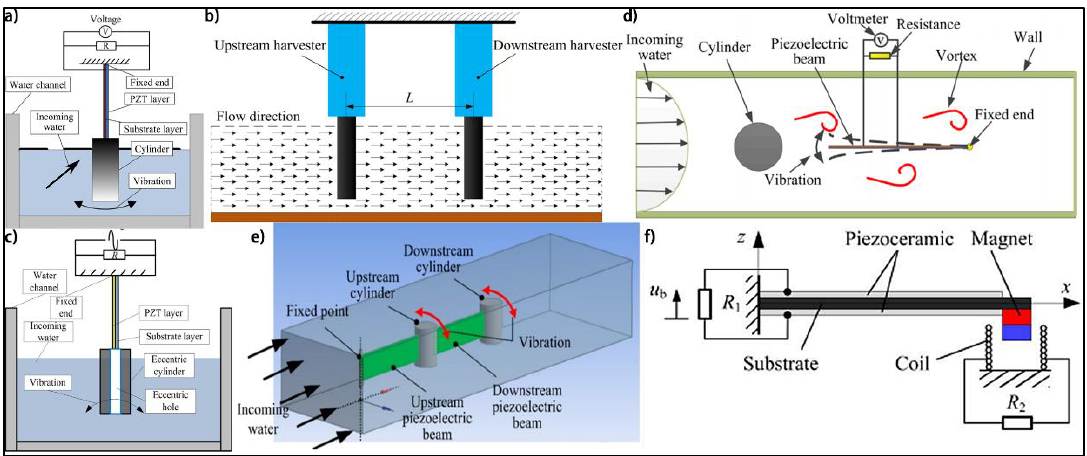
Figure 8. In-depth study of cantilever beam-mass structure energy harvesters. ( a ) Single cylindrical spoiler (reproduced with permission [80]. Copyright 2015, Elsevier). ( b ) Double cylindrical spoiler (reproduced with permission [81]. Copyright 2016, MDPI). ( c ) Eccentric cylindrical spoiler (reproduced with permission [82]. Copyright 2017, MDPI). ( d ) Split trapping device (reproduced with permission [83]. Copyright 2015, Elsevier). ( e ) Transverse double cylindrical trapping device (reproduced with permission [75]. Copyright 2015, MDPI). ( f ) Electromagnetic piezoelectric hybrid vibration energy harvester (reproduced with permission [84]. Copyright 2017, MDPI).